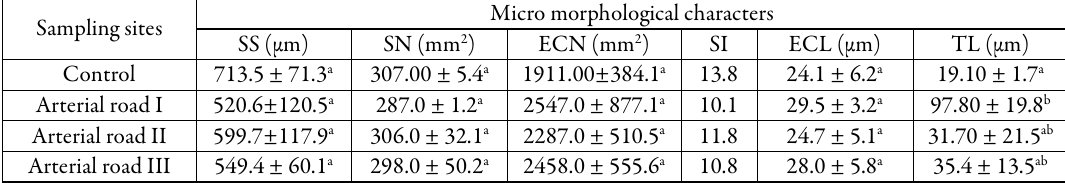
Table 8. Effect of vehicular pollution on micro-morphological variations of Polyalthia longifolia leaves at the study sites in Kumasi